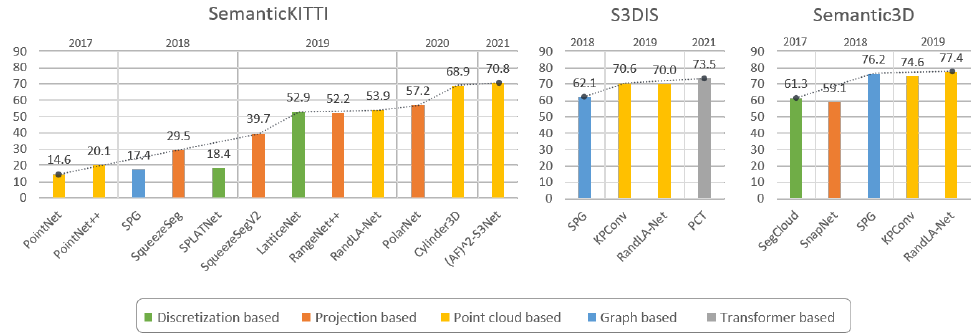
Figure 14. Graphical comparison of the main approaches for Point Cloud Semantic Segmentation in terms of mIoU percentage, on SemanticKITTI [35], S3DIS [44], and Semantic3D [33]